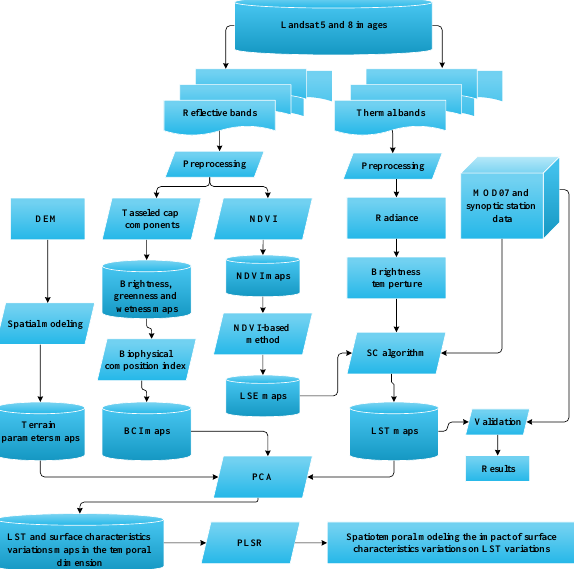
Figure 2. The analytical procedures of the